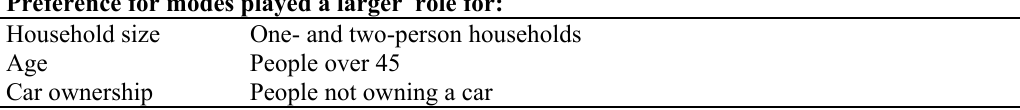
Table 6: Personal and household characteristics related to the question of preferences for modes influenced residential